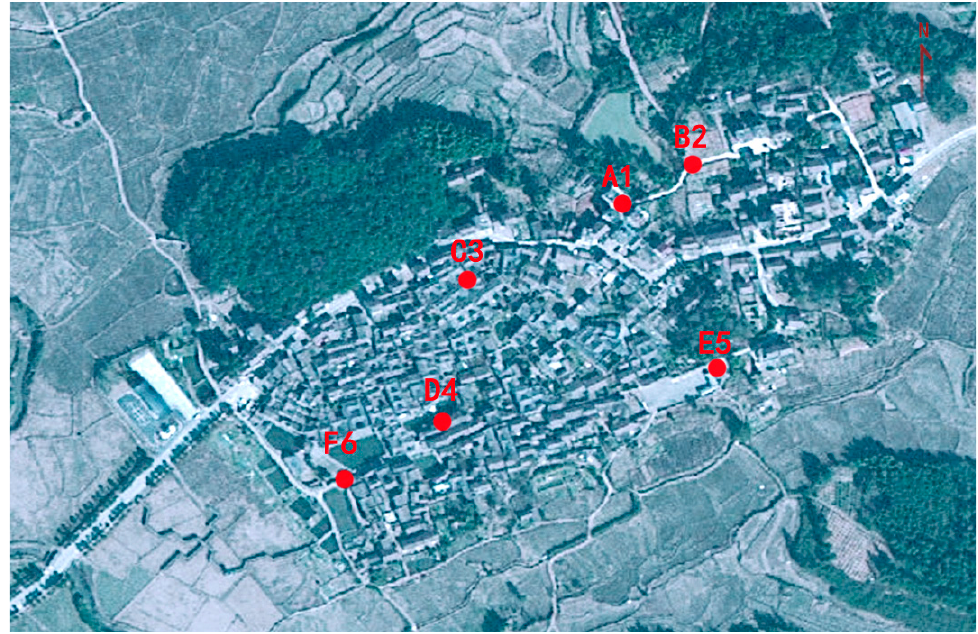
Figure 4. Measured positions in Zhuqiao village. (The red marks are the locations of the actual measurement points.) measurement